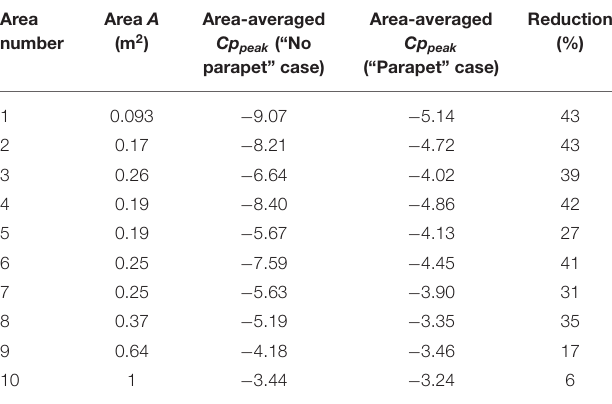
TABLE 3 | Summary of results for the corner areas.